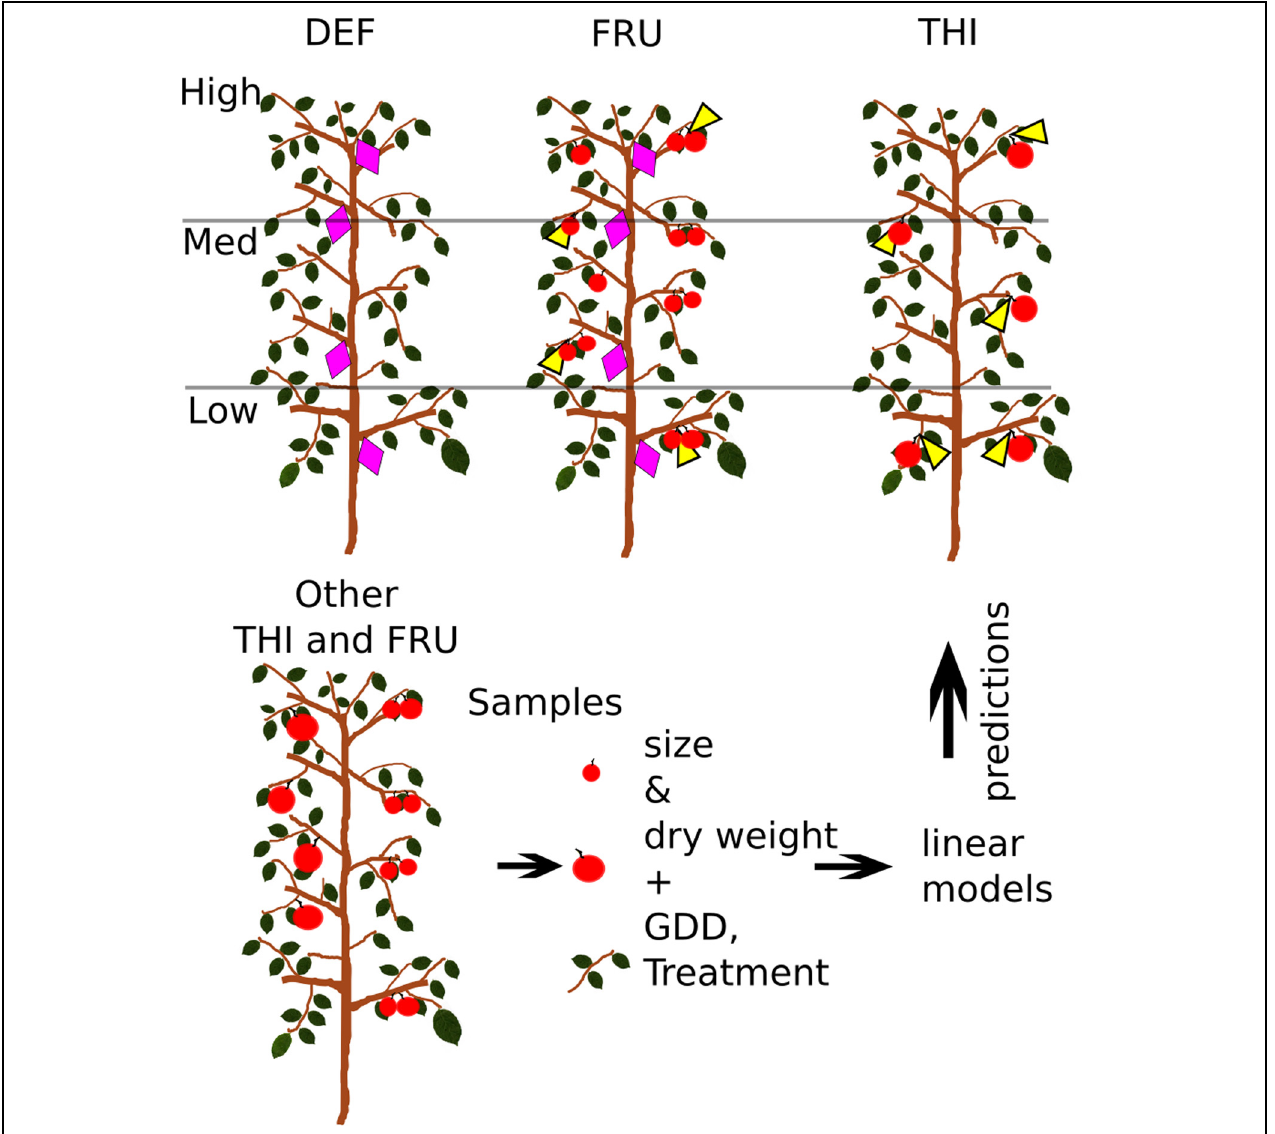
FIGURE 1 | Experimental design. Shoots (violet diamonds) were tagged and measured on fruited (FRU) and defruited (DEF) trees, while fruits (yellow triangles) were measured on fruited and heavily thinned (THI) trees. Fruits and shoots were also sampled from other THI and FRU trees. Sizes, dry weights and treatment of sampled organs, and the growing degree days (GDD) of the date of sampling were used to build linear models, later used to estimate the dry weights of tagged organs.